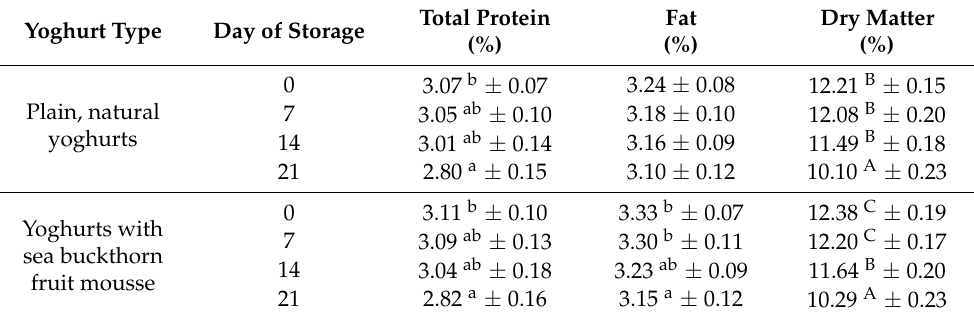
Table 3. Results of basic chemical composition analysis of yoghurts during 21 days of storage in the refrigerated conditions (mean ±